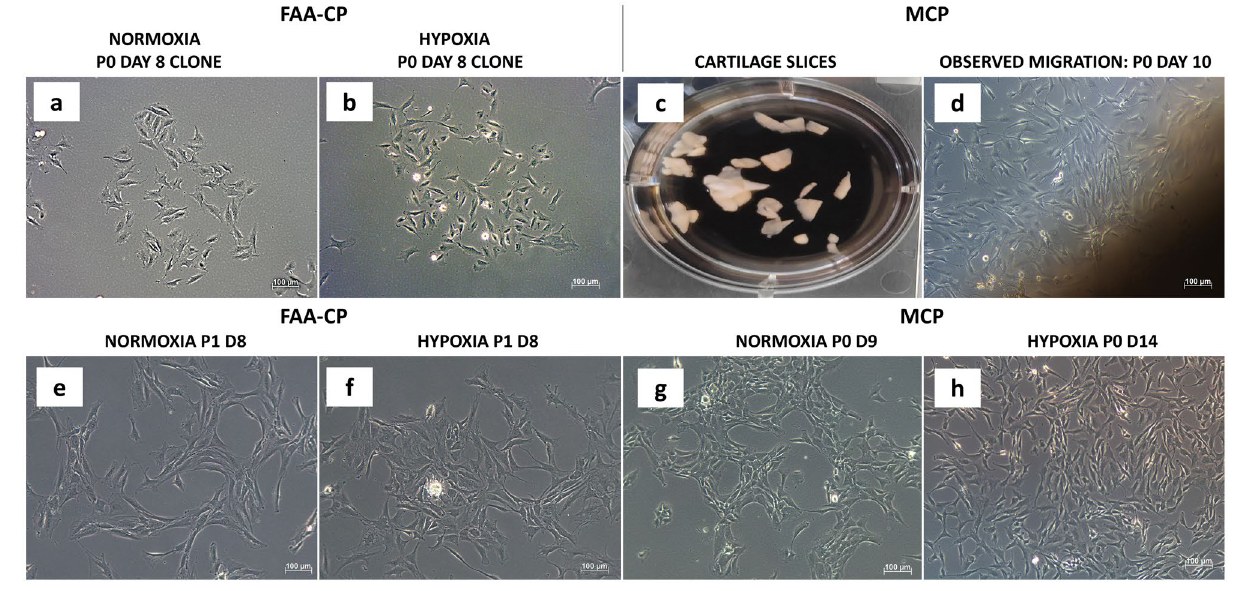
Figure 2. Representative images of FAA-CPs and MCPs during monolayer expansion culture under normoxic and hypoxic conditions. Microscopic analysis observed using phase-contrast microscopy showed that both normoxia and hypoxia FAA-CPs ( a , b , passage 0) demonstrated clonal growth. Migration of chondroprogenitors from the cartilage explants was seen by the 7th day ( c , d , passage 0) in both the microenvironments. Monolayer expanded passage 0 cells in all four groups displayed a comparable spindle-shaped morphology with a typical honeycomb pattern of growth, Magnification 10x ( e – h